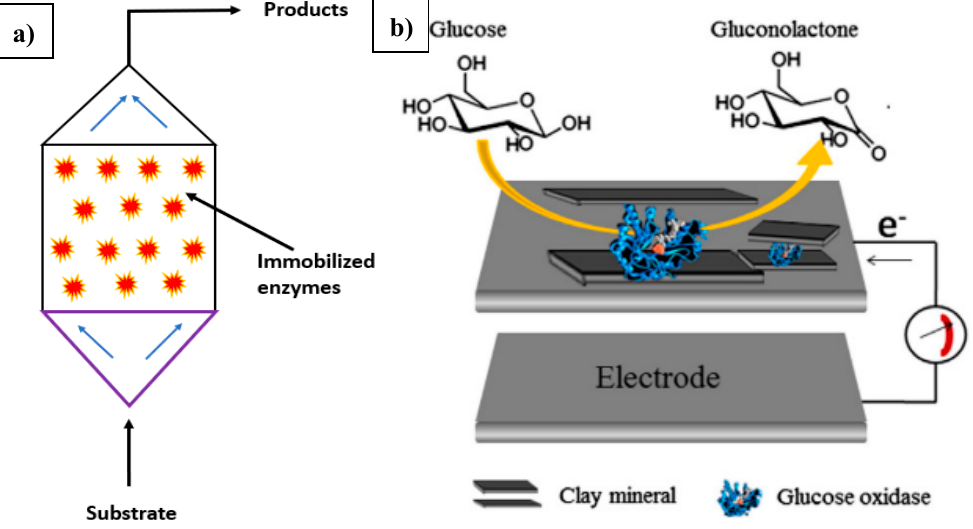
Figure 1. Enzymes immobilised on clay minerals for use as ( a ) biocatalysts and ( b ) biosensors (enzyme-based glucose biosensors)[30].